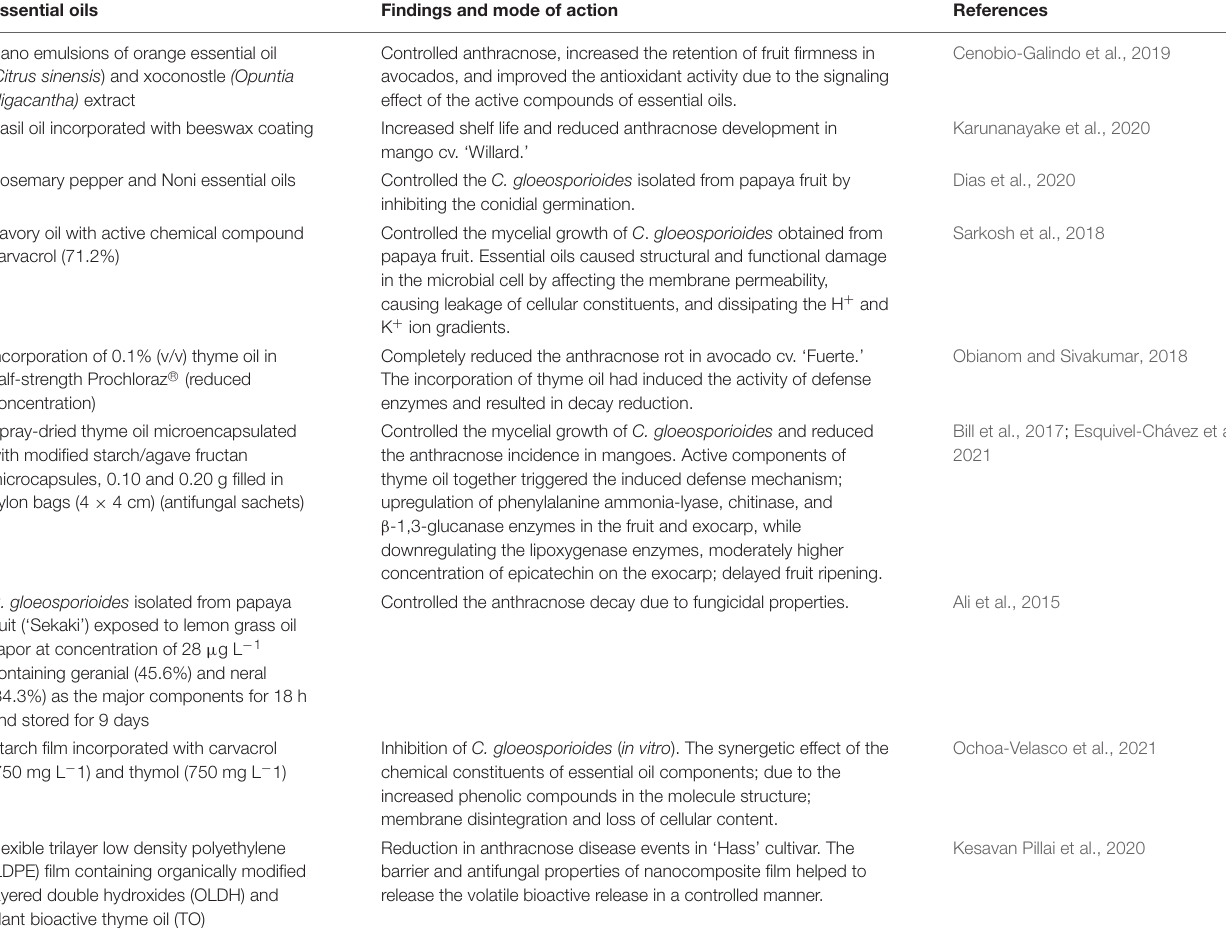
TABLE 3 | Summary of recent developments in essential oils and incorporation of essential oils into wax or films on antifungal properties against C. gloeosporioides